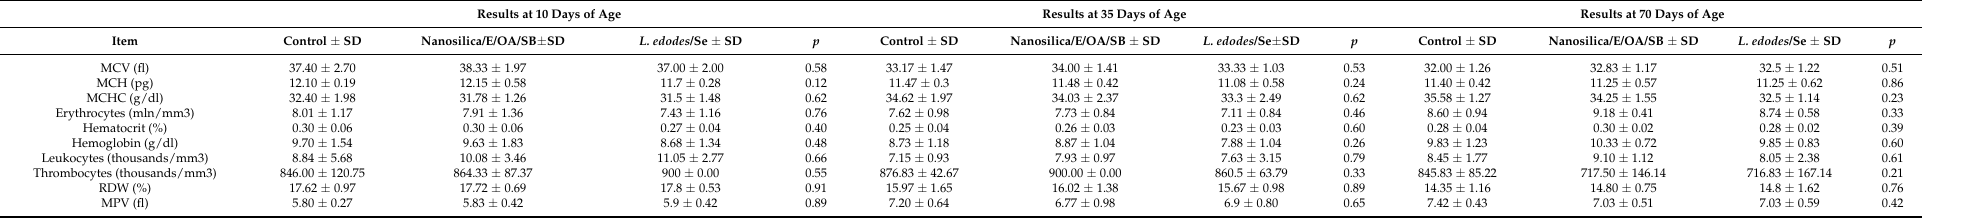
Table 5. Effect of dietary supplementation with nanosilica/E/OA/SB and L. edodes mycelium on hematological parameters at 10, 35, and 70 days of age ( n =